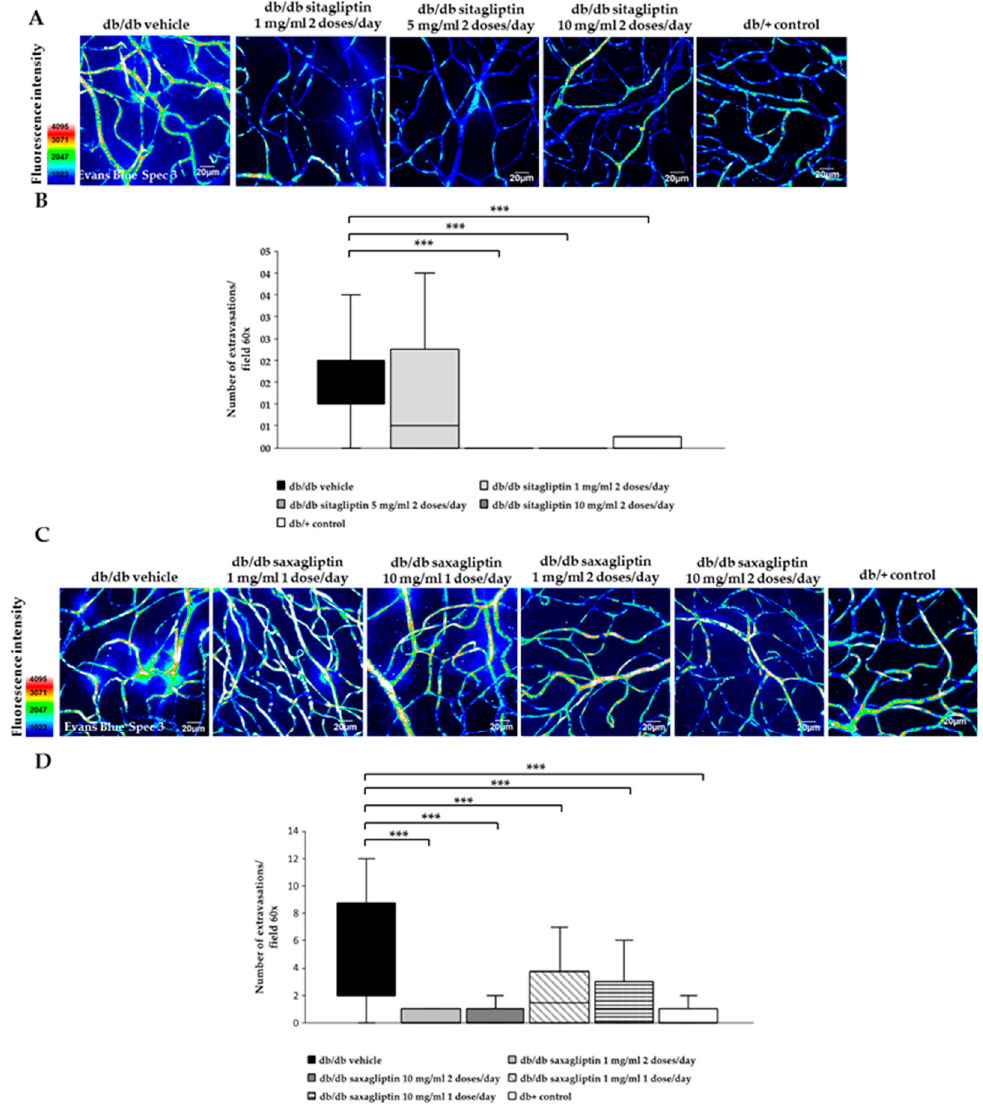
Figure 4. Microvascular abnormalities. ( A , C ) Confocal images of vascular permeability assessed by Evans blue dye leakage in retinal whole mounts. Treatments with sitagliptin are compared in panel ( A ) and saxagliptin treatments in panel ( C ). Spec3, fluorescent spectral signature 3. Scale bars, 20 µ m. ( B , D ) Quantification of extravasations per 60x field of the retina. Treatments with sitagliptin are compared in panel ( B ) with saxagliptin treatments in panel ( D ). In graph ( B ) vehicle is presented with black bars, sitagliptin 5 mg/mL 2 doses/day with grey bars, sitagliptin 10 mg/mL 2 doses/day with dark grey bars and control mice with white bars. In graph ( D ) vehicle is presented with black bars, saxagliptin 1 mg/mL 1 dose/day with white bars with diagonal lines, saxagliptin 10 mg/mL 1 dose/day with white bars with horizontal lines, saxagliptin 1 mg/mL 2 doses/day with grey bars, saxagliptin 10 mg/mL 2 doses/day with dark grey bars and control mice with white bars. n = 3 mice per group, 25–30 fields per animal were analyzed. *** p < 0.001.